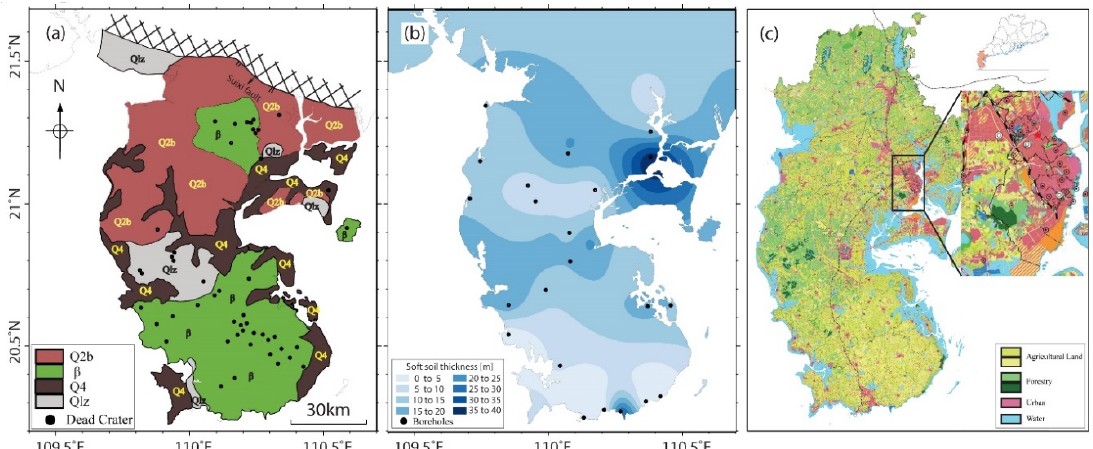
Figure 2. Geology and land use maps of the Leizhou Peninsula (LZP) (modified from [3,15,16]). ( a ) is the geology map with four kinds of compressible deposits: Beihai group of middle Pleistocene age (Q2b); basalt of Himalayan Period ( β ) with lots of dead craters represented by black dots; Zhanjiang group of Lower Pleistocene age (Qlz); recent sediments of Quaternary age (Q4); the black dots represent the dead craters in LZP; ( b ) is the distribution of soft soil thickness derived from the interpolation of 22 boreholes represented by black dots [16]; ( c ) is the land use map derived from Zhanjiang Municipal Bureau of Land and Resources (ZMBLR) [3], the inset is an enlarged view of Zhanjiang city.